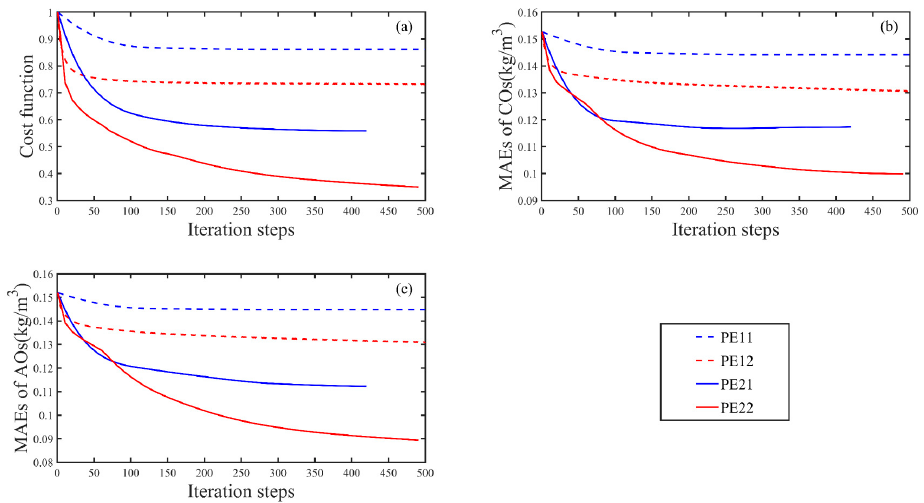
Figure 6. In practical experiments, variation of results with iteration steps in PE11 (blue dashed line), PE12 (red dashed line), PE21 (blue solid line) and PE22 (red solid line): ( a ) normalized cost function, ( b ) MAEs between COs and the simulated SSCs, and ( c ) MAEs between AOs and the simulated SSCs.